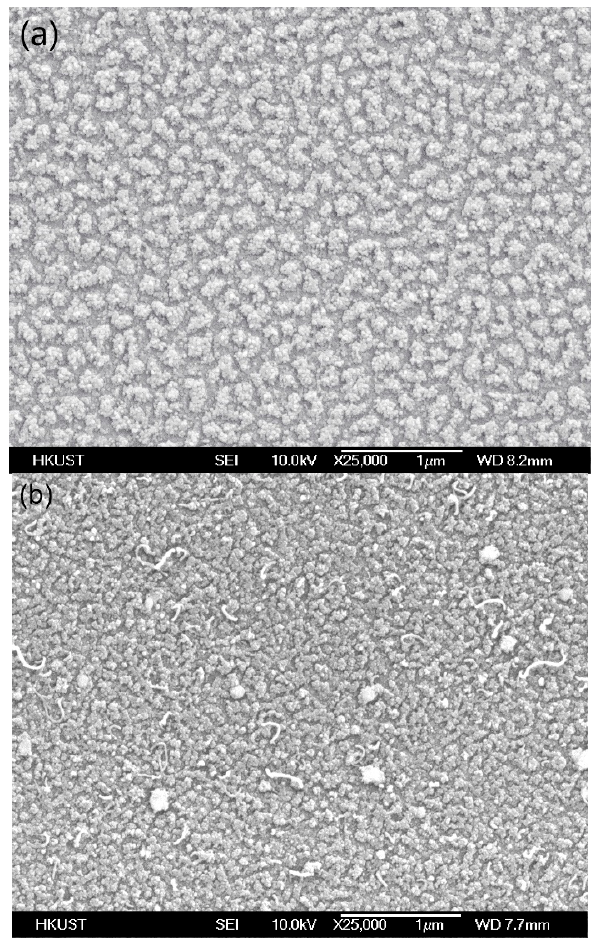
Figure 7. CNT synthesis results with ( a ) SiO 2 and ( b ) Al 2 O 3 with Ni–Al–Ni (1 nm–0.5 nm–1 nm) multilayer catalyst at 450 °C.